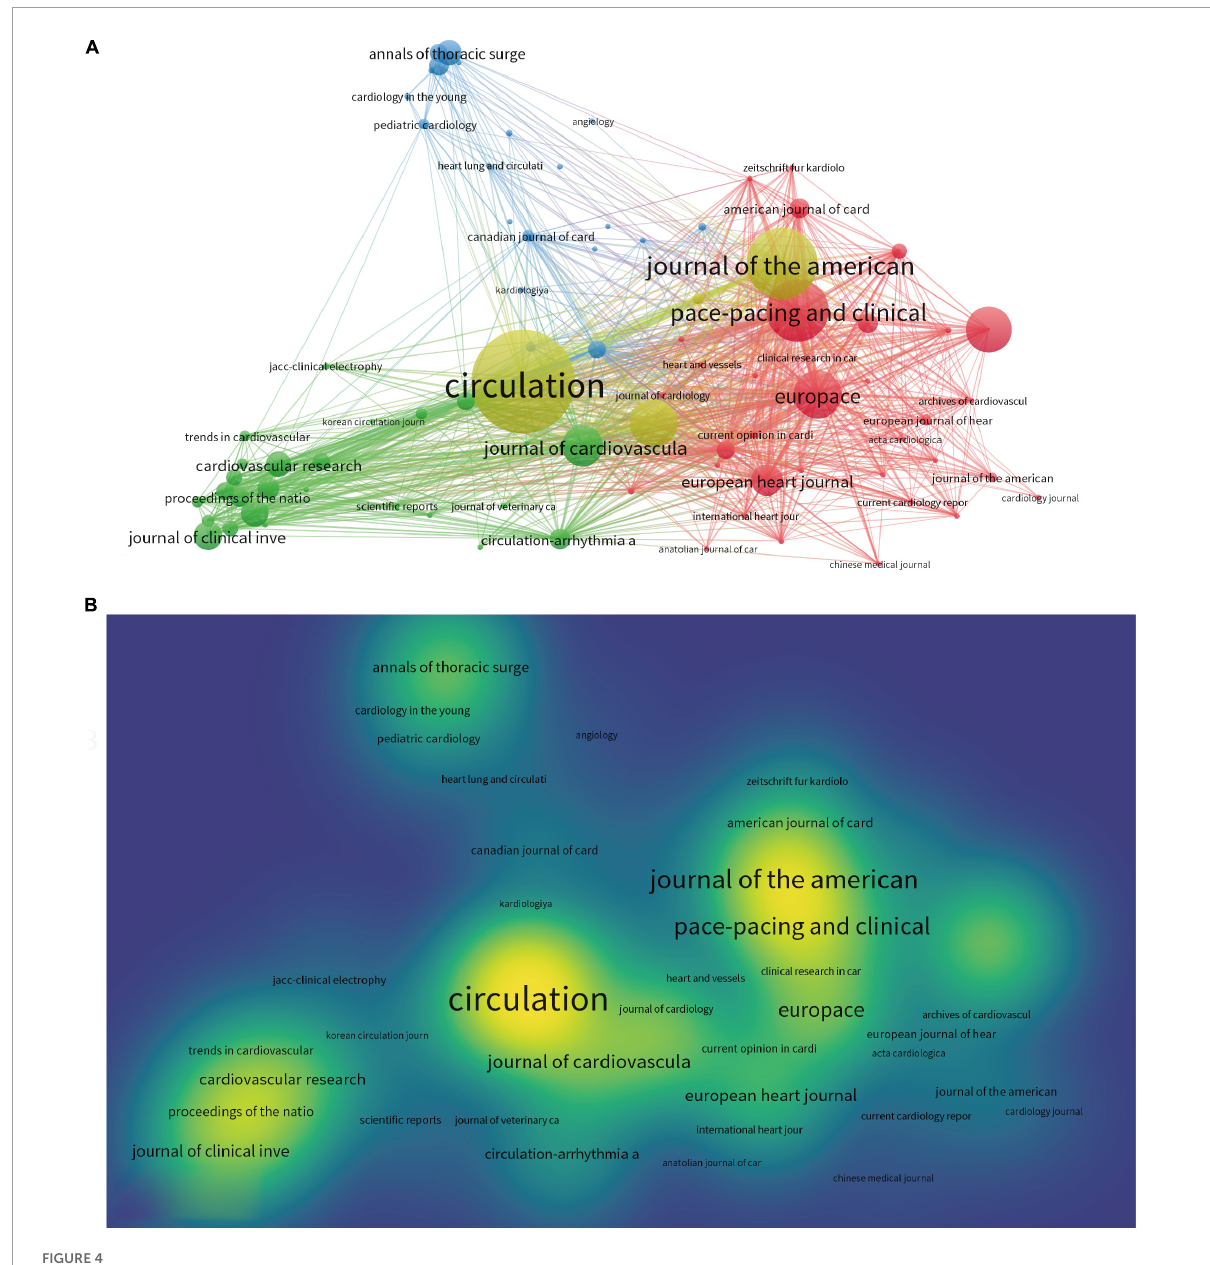
FIGURE4 (A) Network map of journals analysis based on VOS viewer. (B) Density map of journals analysis based on VOS